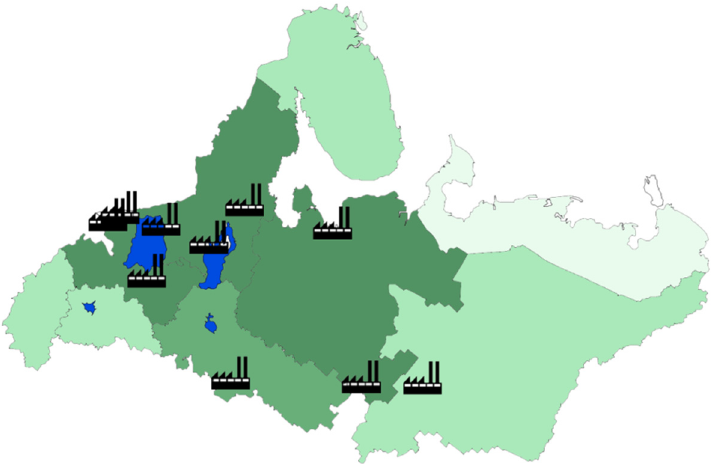
Figure 1. Map of the largest pulp and paper mills in the Northwestern Federal District of the Russian Federation; shades of green indicate production volume, blue is for water bodies.